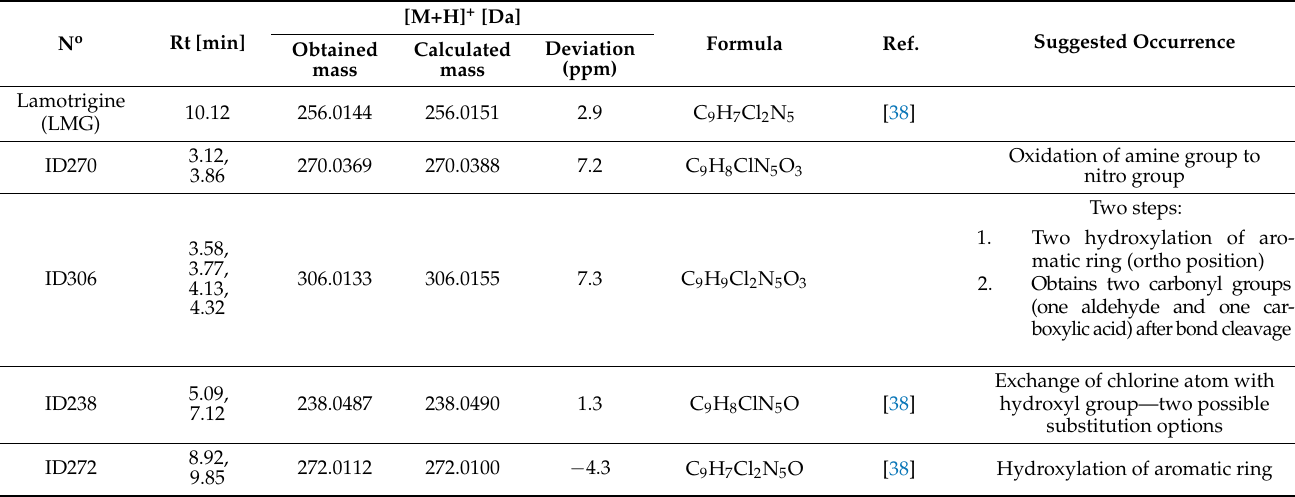
Figure 5. Lamotrigine and its major transformation products. Table 5. Lamotrigine transformation products’ identification